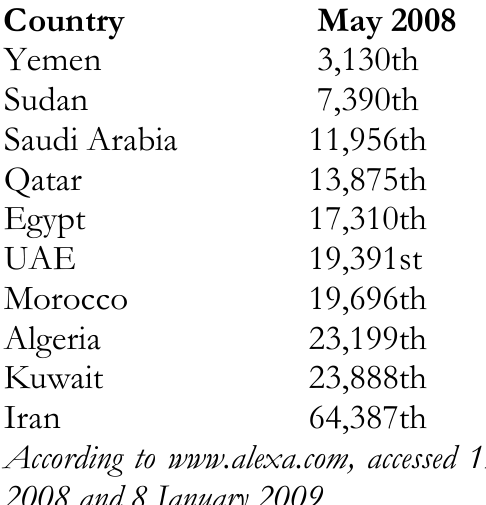
Table 1: Alhurra’s position among websites most visited Arab internet users